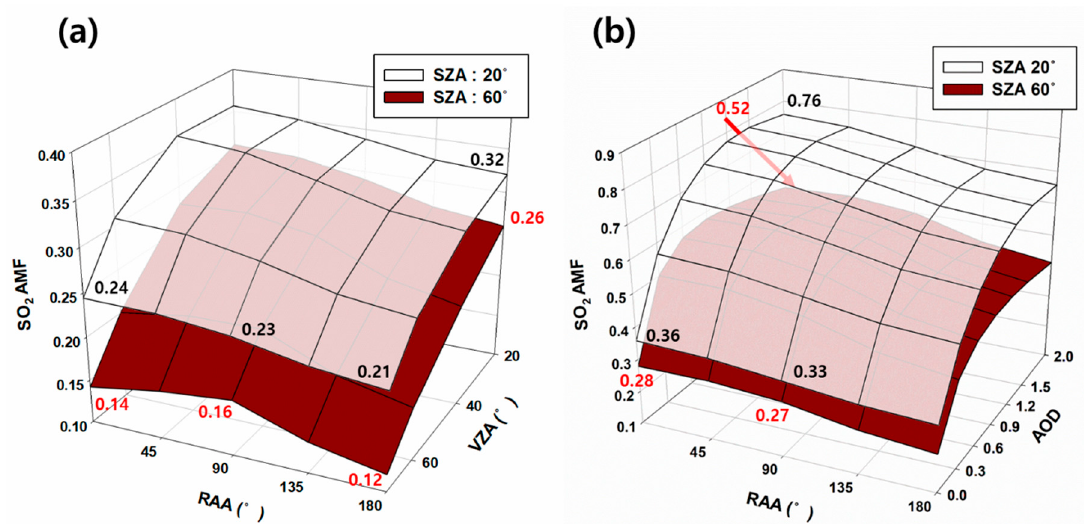
Figure 4. Changes in PBL SO 2 AMF ( a ) as a function of the relative azimuth angle (RAA) and viewing zenith angle (VZA) at low and high solar zenith angles (SZA) under the conditions of surface reflectance = 0.05, O 3 vertical column density (VCD) = 275 DU, wavelength = 318 nm, and aerosol optical depth (AOD) = 0, and ( b ) as a function of RAA and AOD at low and high SZA under conditions of surface reflectance = 0.05, O 3 VCD = 275 DU, wavelength = 318 nm, and aerosol peak height (APH) = 0 km.